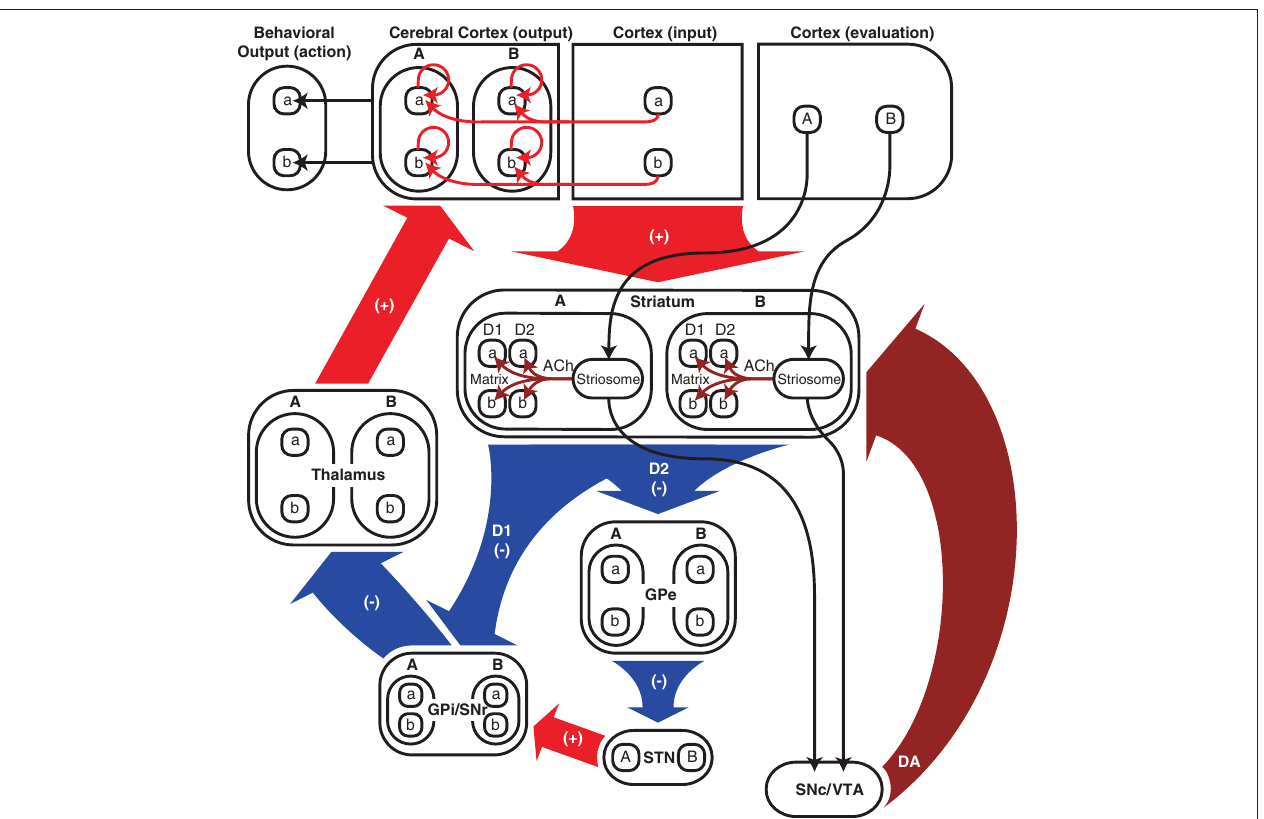
Figure 5 | Schematic diagram of cortico-basal ganglia-thalamo-cortical network model. Red arrows and “( + )” indicate excitatory glutamatergic projections, blue arrows and “( − )” indicate inhibitory GABAergic projections, burgundy arrows indicate modulatory connections, i.e., responsibility signals and dopamine signals. Responsibility signals could potentially be conveyed from striosomes by cholinergic interneurons (ACh), and could modulate dopamine signals (DA) reaching D1 and D2 medium spiny neurons (MSNs) from the SNc/ VTA (not explicitly included in our computational model). In addition to its input from the thalamus, the output region of the neocortex receives inputs from the input region of the neocortex and has self-feedback connections. “a” and “b” represent actions and action-related signals (e.g., action-value or action-selection signals), and “A” and “B” represent modules. “D1” and “D2”